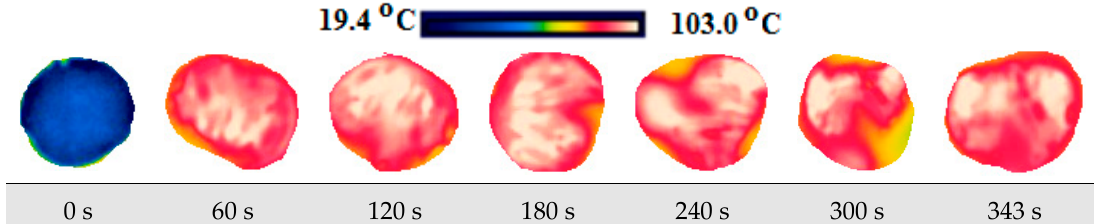
Figure 20. Thermal images of persimmon with 9 mm at 460 W.